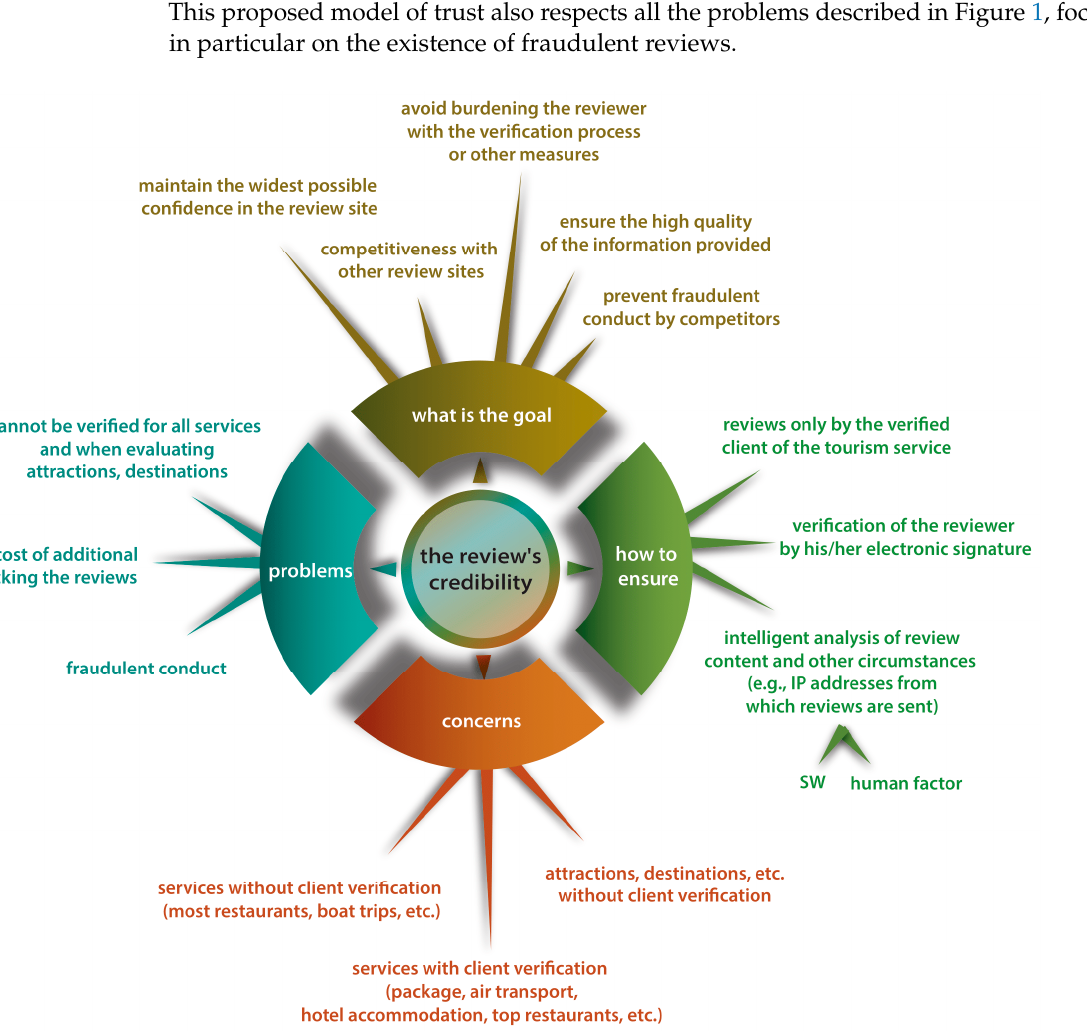
Figure 1. Factors and contexts of achieving trust in reviews on review sites. Source: Based on Filieri et al. (2015), Cardoso et al. (2018), Barbado et al. (2019), Wu et al. (2020), TripAdvisor (2020b), Zheng et al. (2021).